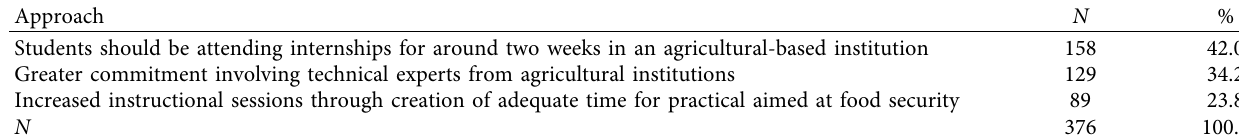
Table 4: Students’ views on specific approaches that may help them develop more skills for food